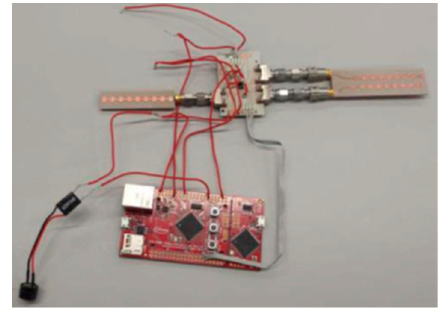
Figure 7. Picture of the radar prototype [23].